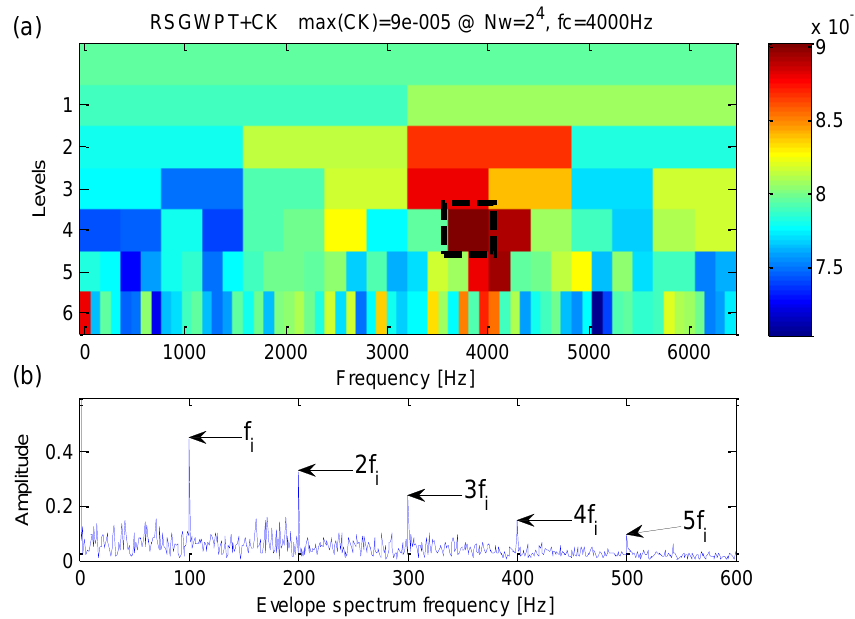
Figure 6. ( a ) The results of the improved kurtogram; ( b ) the results of the corresponding envelope spectrum.